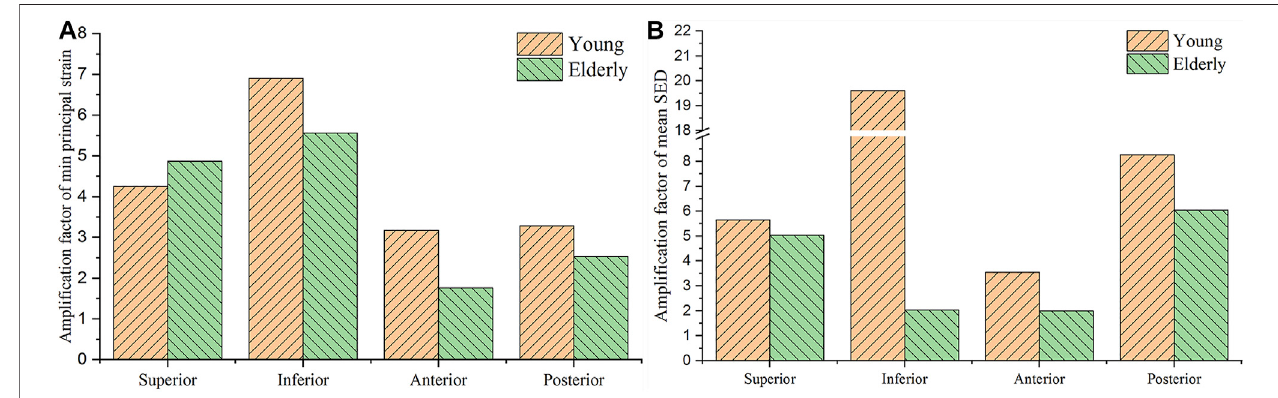
FIGURE 4 | Comparisons of the ampli fi cation factors of the minimum principal strain (A) and the mean SED (B) in the four quadrants of the femoral neck in the young and the elderly.